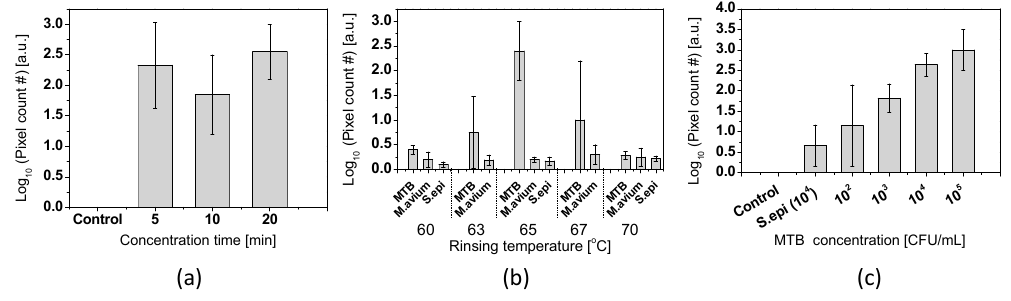
Figure 13. ( a ) Concentration time test (N = 3); ( b ) Specificity result with genomic DNA of MTB, M. avium , and S. epidermidis at various rinsing temperature (N = 3). The concentration of the bacteria before extraction is 10 4 CFU/mL. ( c ) Sensitivity test with MTB DNA (N =